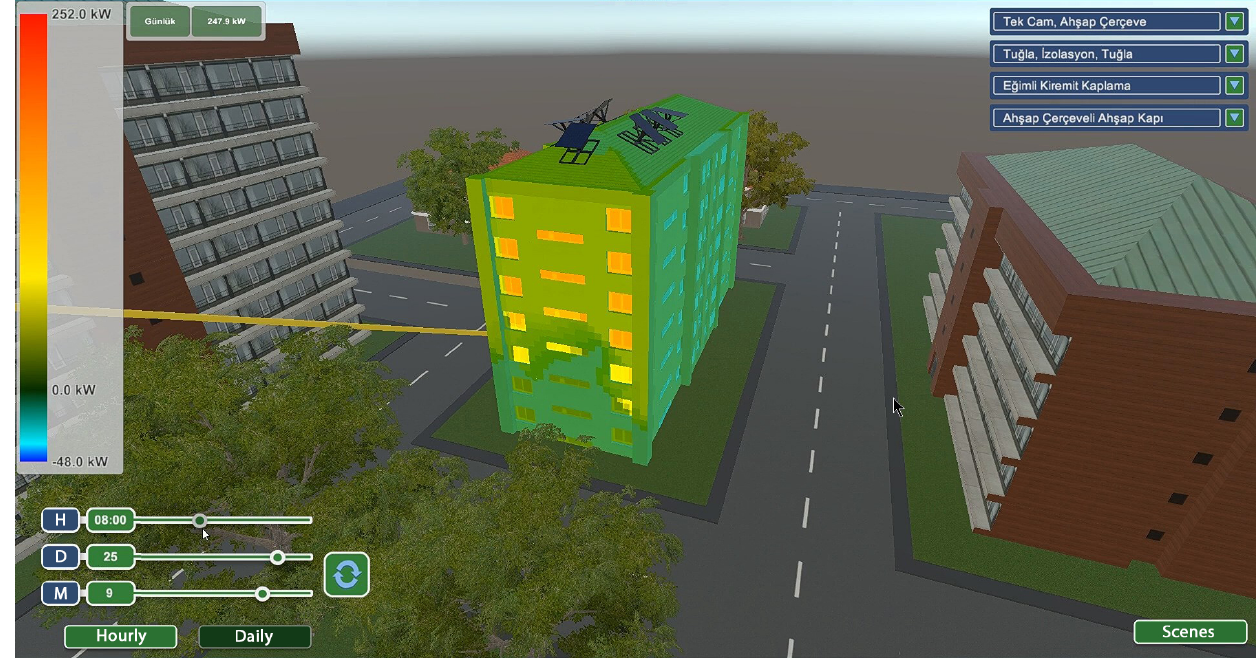
Figure 3. Estimation of the solar irradiation of buildings for a specific date and time. In this case the surrounding vegetation and the type of the receiving material is also taken into account in the estimations. (Image courtesy of